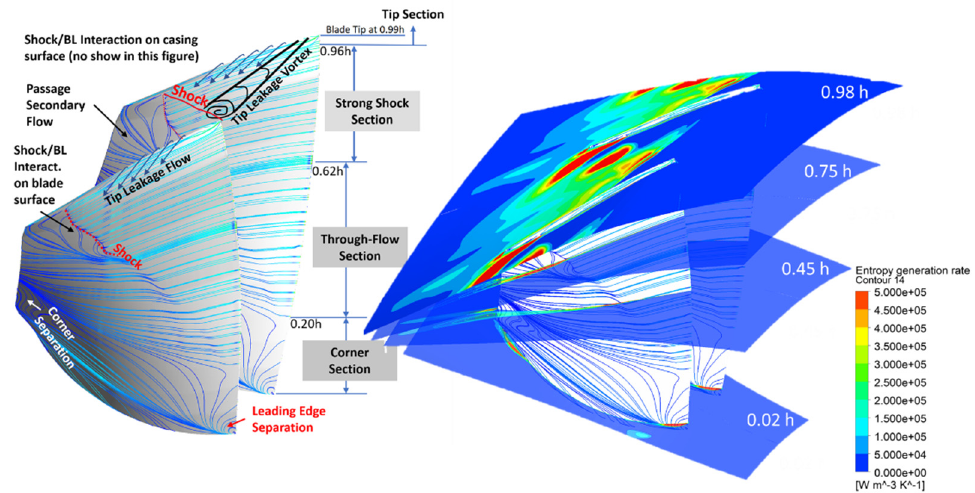
Figure 10. Flow structures in R67 at PE and the typical contours of EGRs. Table 2. Comparison of entropy generation for the